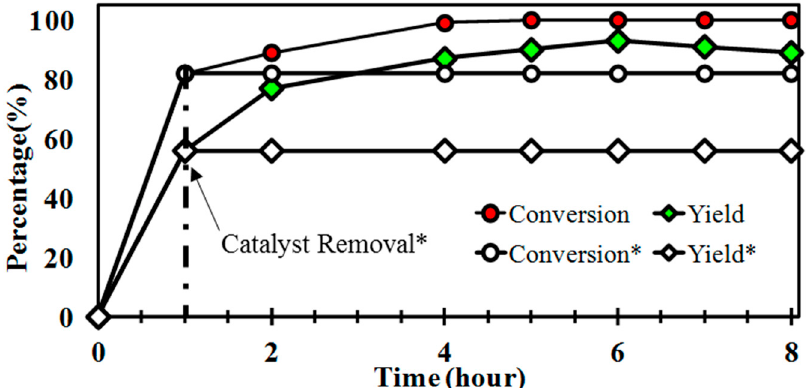
Figure 1. Time courses of the reduction of benzaldehyde in the presence of formic acid and Pd/carbon catalyst. Reaction conditions: Pd/carbon (50 mg), benzaldehyde (1 mmol), formic acid (1.5 mmol), THF (3 mL), temp. (100 °C). *Time course of the reaction when the solid catalyst was removed from the reaction mixture after 1 h by filter (open marks).